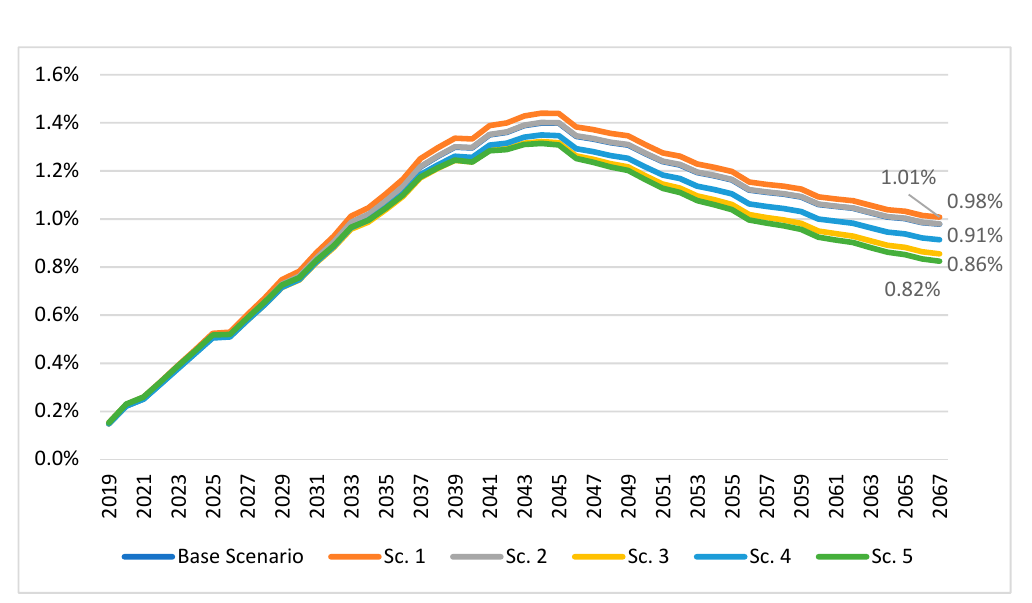
Figure 11. Savings in PAV/GDP each year, with the application of the SF. Various scenarios. Source: Own elaboration.